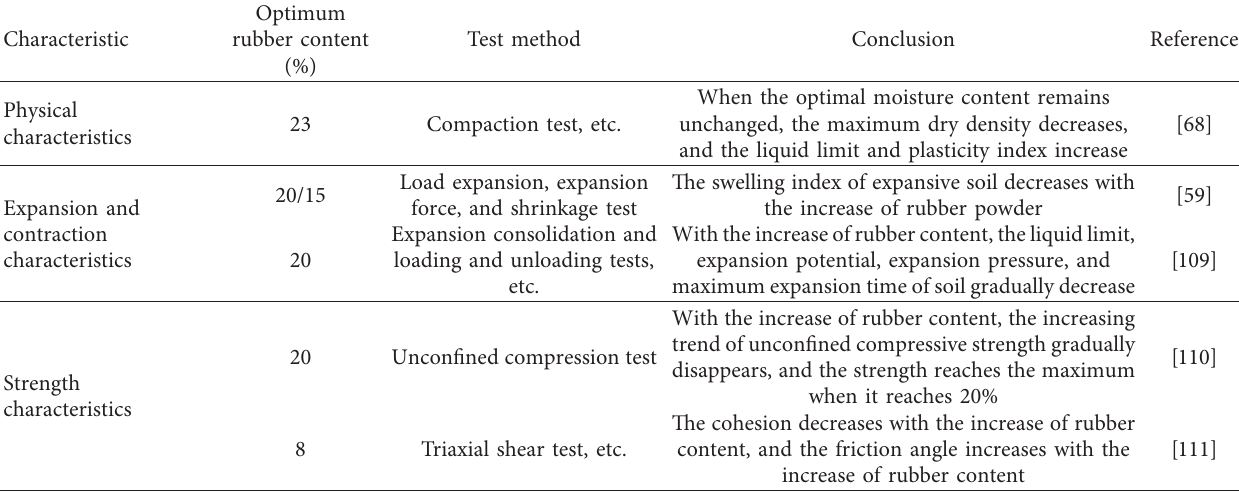
Table 7: Characteristics of rubber reinforced expansive